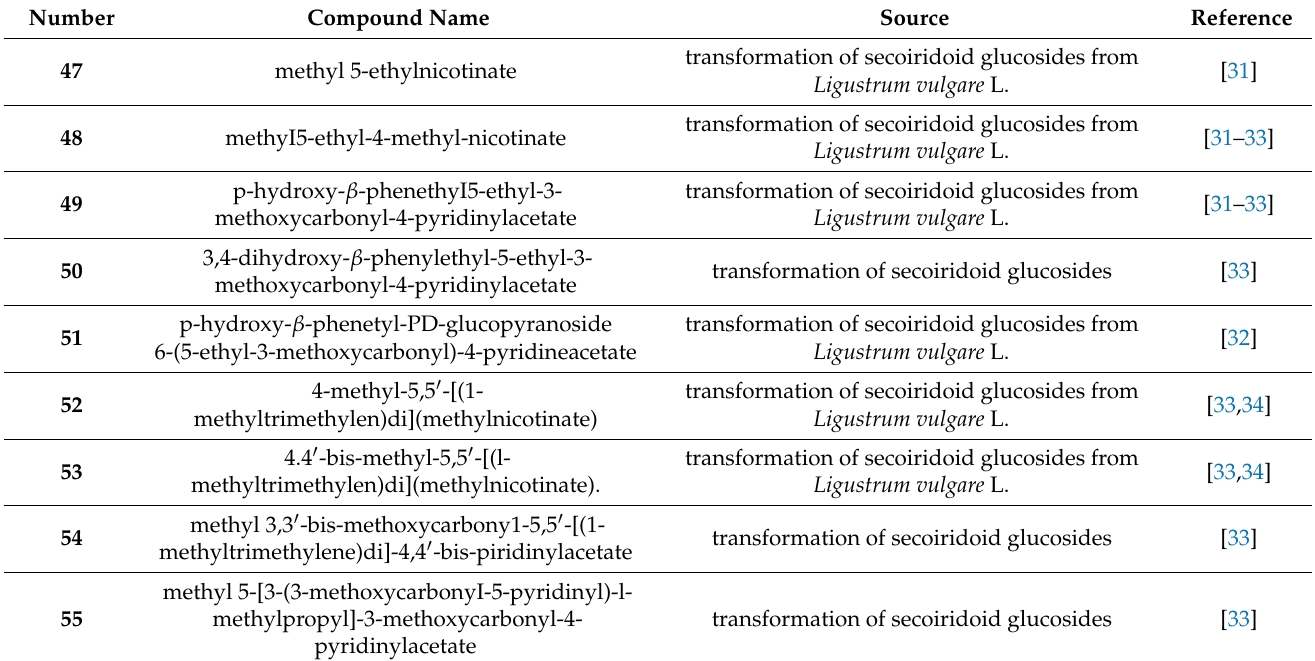
Table 4. Pyridine alkaloids derived from secoiridoids (Type IV).